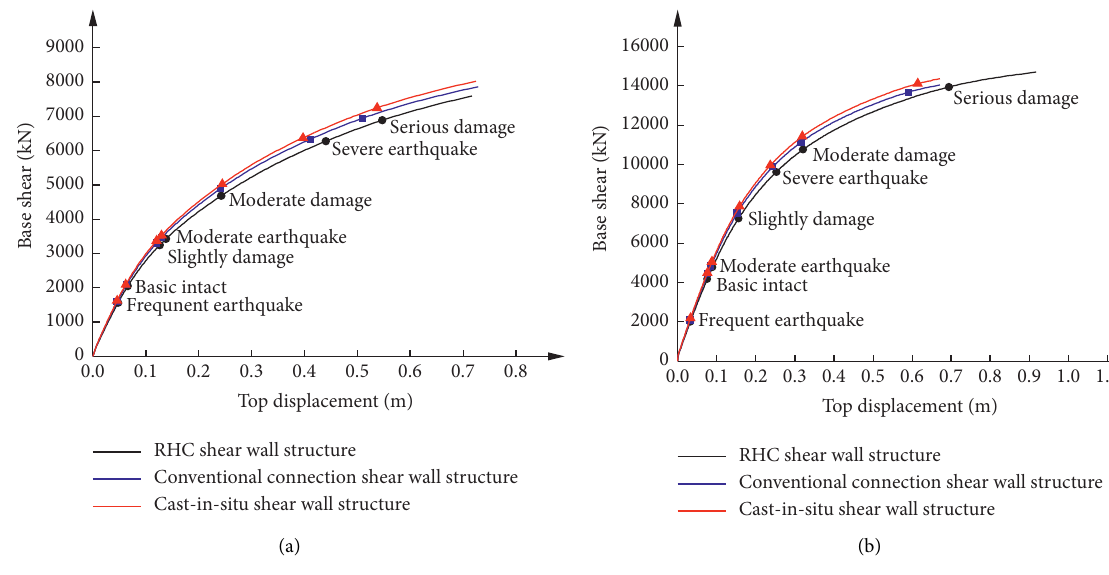
Figure 14: Seismic performance evaluation curve. (a) In x direction. (b) In y